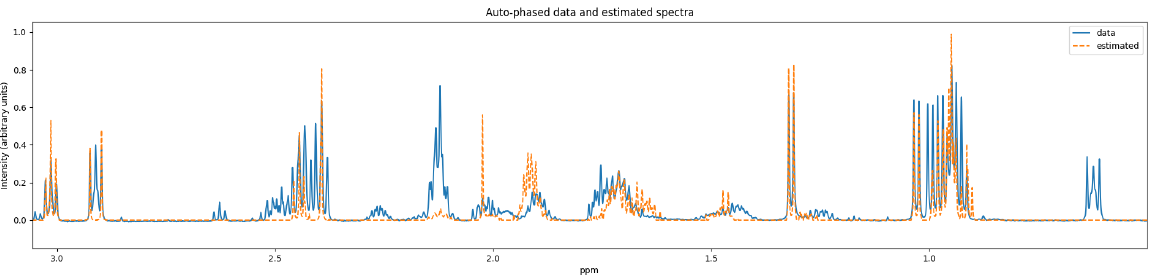
Figure 7. Close-up of Figure 6.